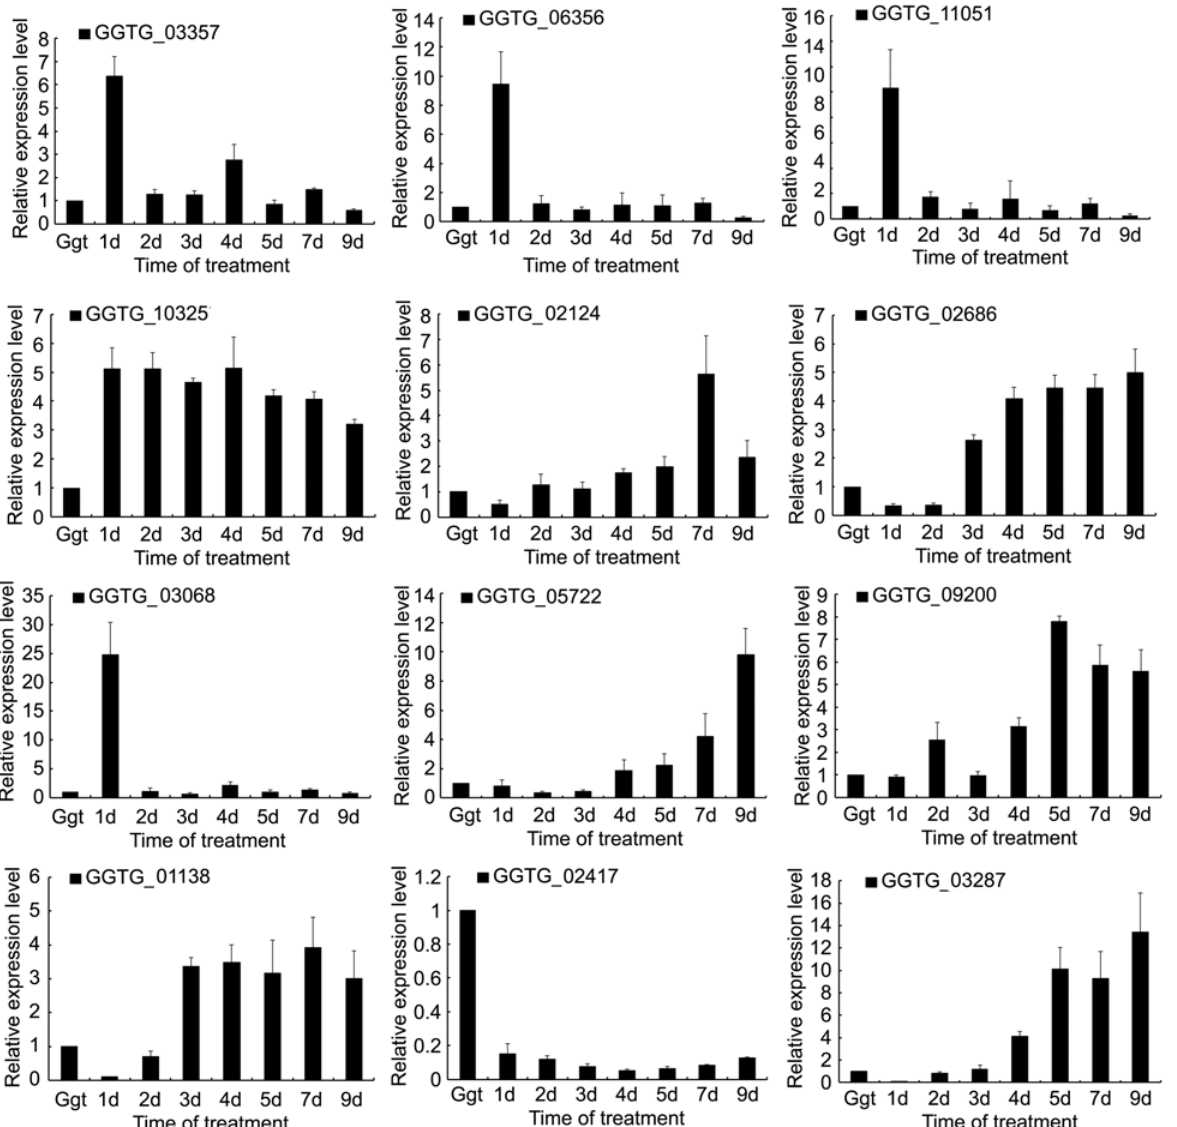
Fig 5. Relative expressions of selected DEGs in Ggt culture and Ggt -infected wheat roots. The x-axis shows the sample: Ggt culture, and infected wheat roots at 1 day, 2 days, 3 days, 4 days, 5 days, 7 days and 9 days post